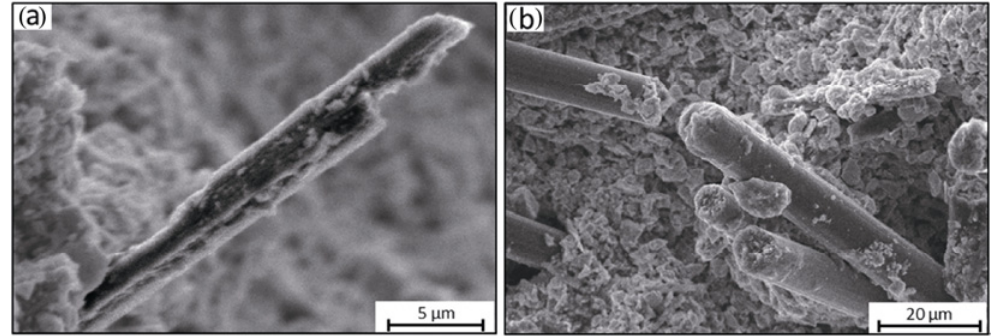
Fig. 2 Carbon fibre morphologies: (a) green body obtained by ball milling process, and (b) green body obtained by new process described in this